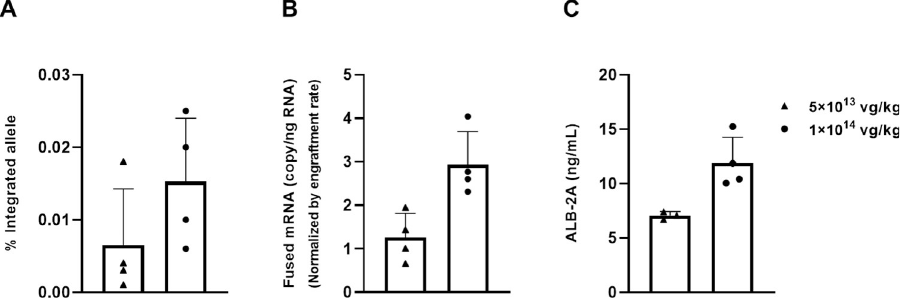
Fig 7. Analyses of terminal samples from PXB mice treated with Vt196. Adult PXB mice engrafted with human hepatocytes were treated with 1 × 10 14 or 5 × 10 13 vg/kg of Vt196 at 5 months of age. Animals were sacrificed at 8 weeks post-dosing and terminal samples were analyzed for (A) site-specific genomic DNA integration in the liver, (B)